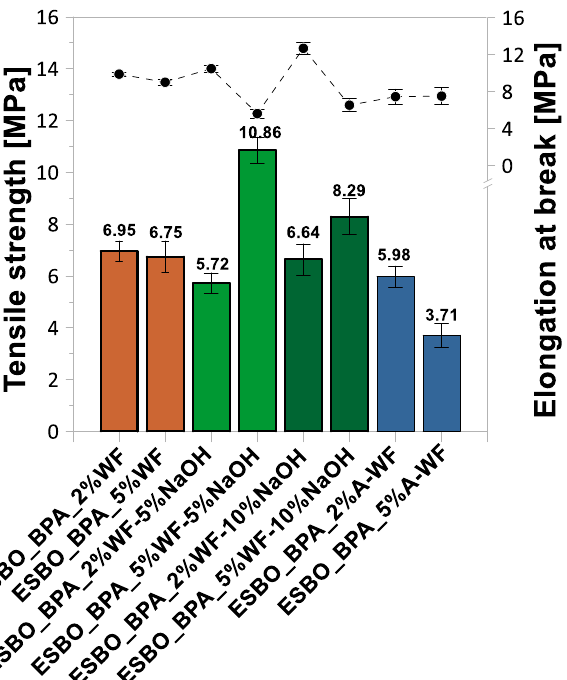
Figure 5. Tensile strength and elongation at break of compositions based on ESBO_BPA filled with waste oak flour.